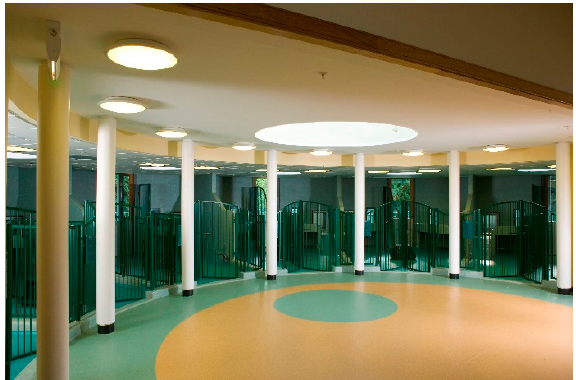
Figure 1. An example of a Waltham dog pod allowing the dogs both visibility and privacy between pens.